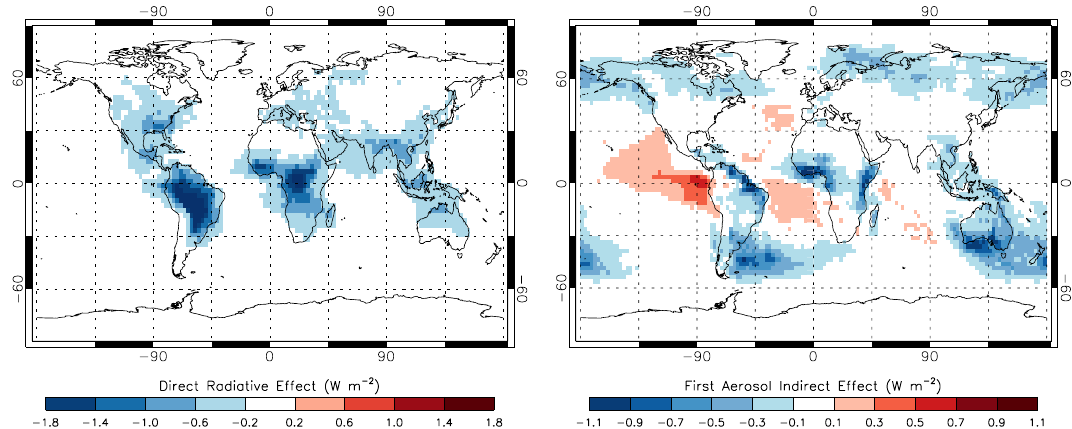
Fig. 7. Annual mean all-sky DRE (left), and first AIE (right) associated with the perturbation in cloud droplet number concentration, due to biogenic SOA (expt. 4) relative to an equivalent simulation with no biogenic SOA (expt.